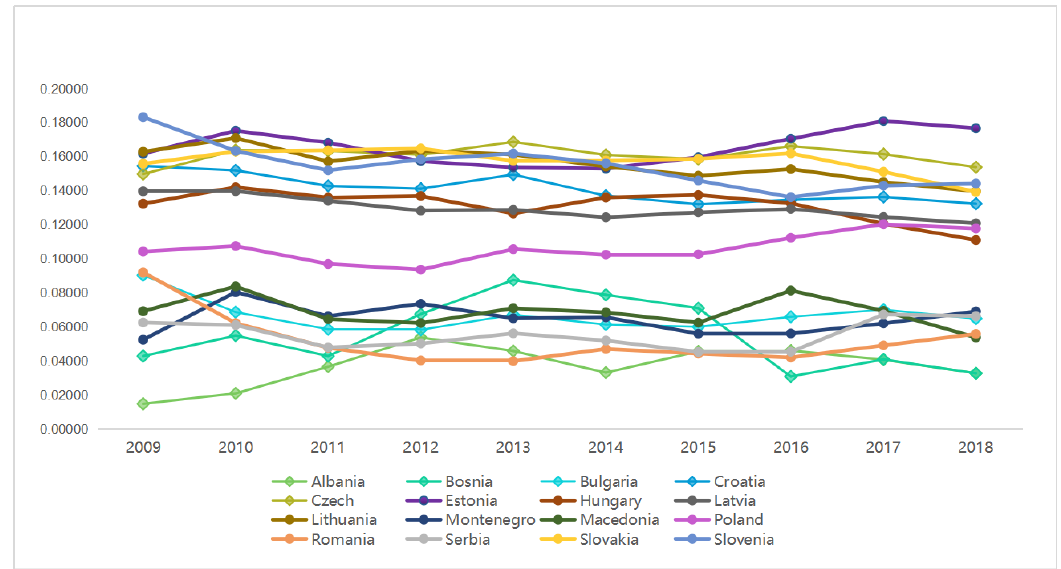
Figure 7. Evaluation results of technical climate in CEE countries from 2009 to 2018.